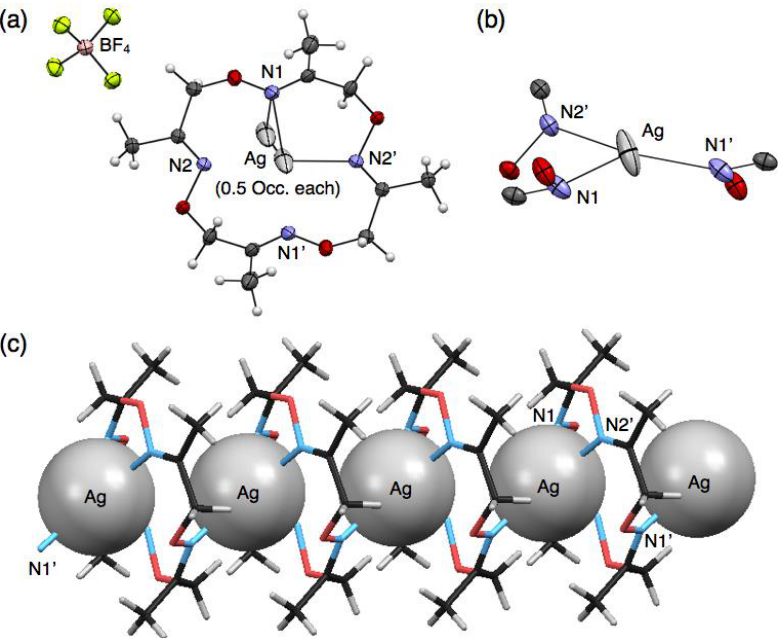
Figure 4. Crystal structure of [Ag( 1 )] structure represented with 50% thermal ellipsoids; ( c ) A side view represented with space fill (Ag) and stick ( 1 ) models. BF 4− anions and disordered Ag I cations are omitted for clarity in ( b ) and ( c ).